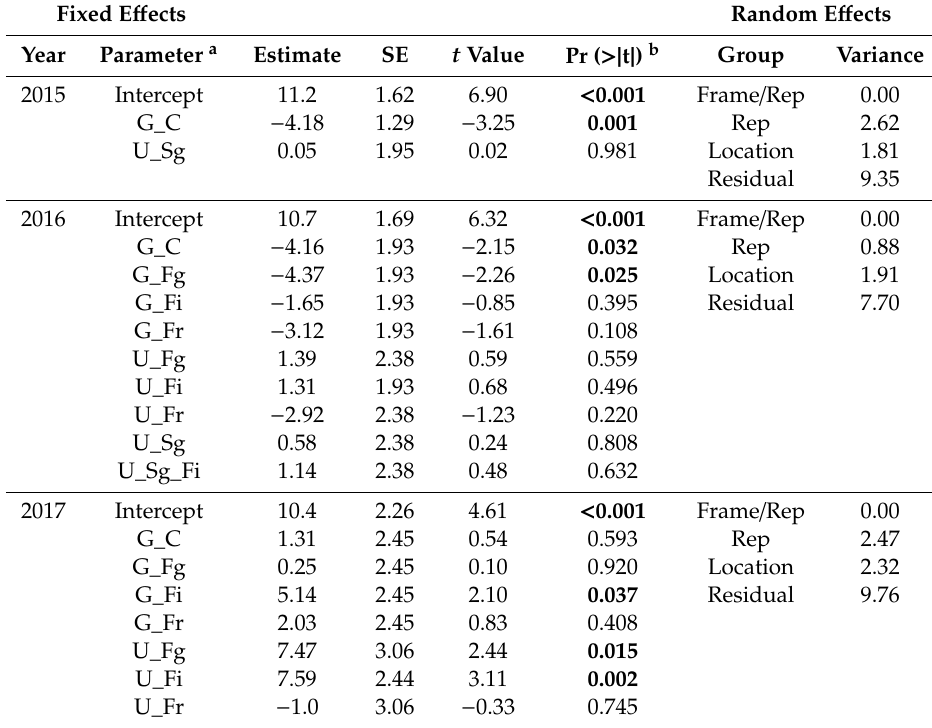
Table 7. The response of native grass cover to grazing and / or herbicide treatments, analyzed using a linear mixed e ff ects model. All treatments (parameters) are with respect to the ungrazed control treatment (U_C), which is the intercept in the model. In 2015 only the grazed (G) and ungrazed control, and the spring applied herbicide treatment results are shown, because fall herbicide application had not yet occurred. Results are based on log transformed native grass